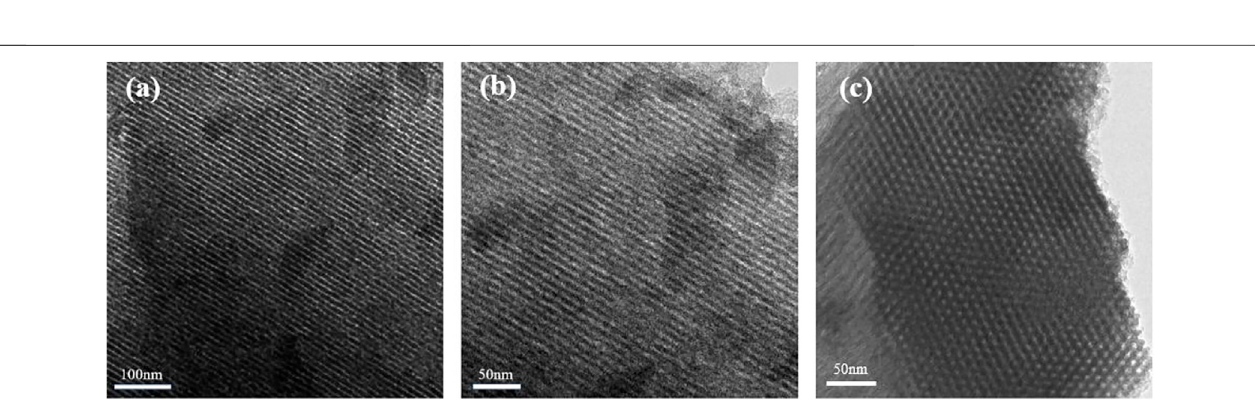
Frontiers in Chemistry |